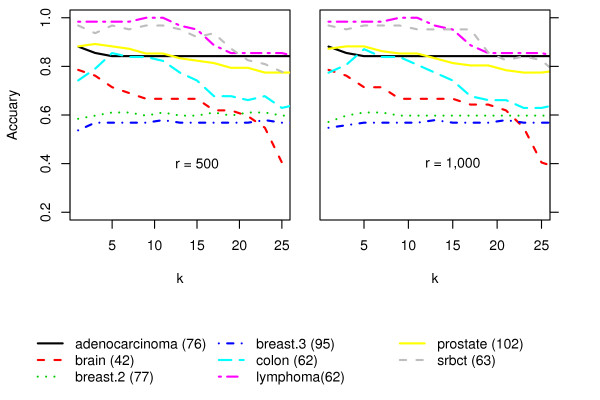
The effect of k.